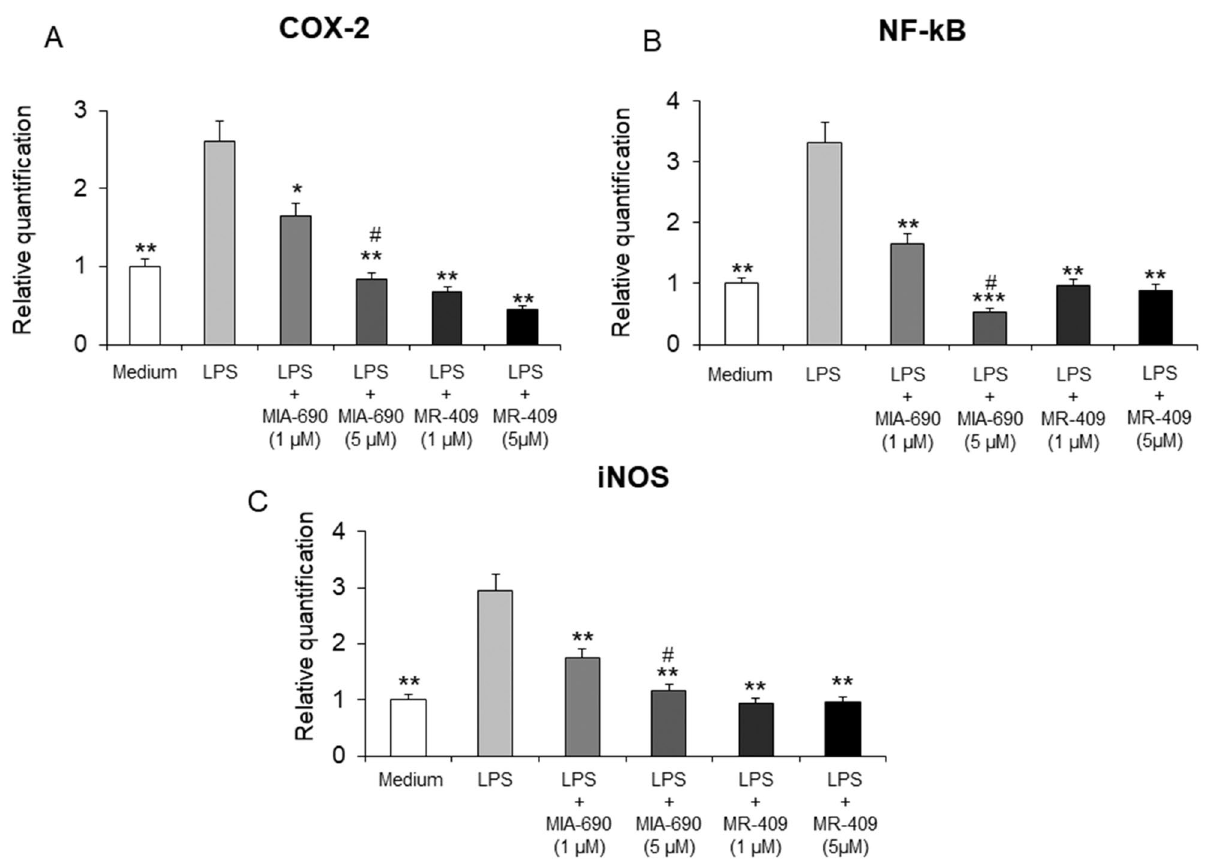
Figure 3. Relative quantification of COX-2 ( A ), NF-kB ( B ) and iNOS ( C ) gene expression in mouse colon specimens treated with MIA-690 (1 and 5 μM) and MR-409 (1 and 5 μM), ex vivo (n = 5 for each group of treatment). Data were calculated using the 2 -ΔΔCt method, normalized to β-actin mRNA levels, and expressed relative to control (calibrator sample, defined as 1.00). Data are expressed as means ± S.E.M. and analyzed by analysis of variance (ANOVA) followed by Bonferroni post-hoc test * p < 0.05, ** p < 0.01, *** p < 0.005 versus LPS; # p < 0.05 versus treatment with